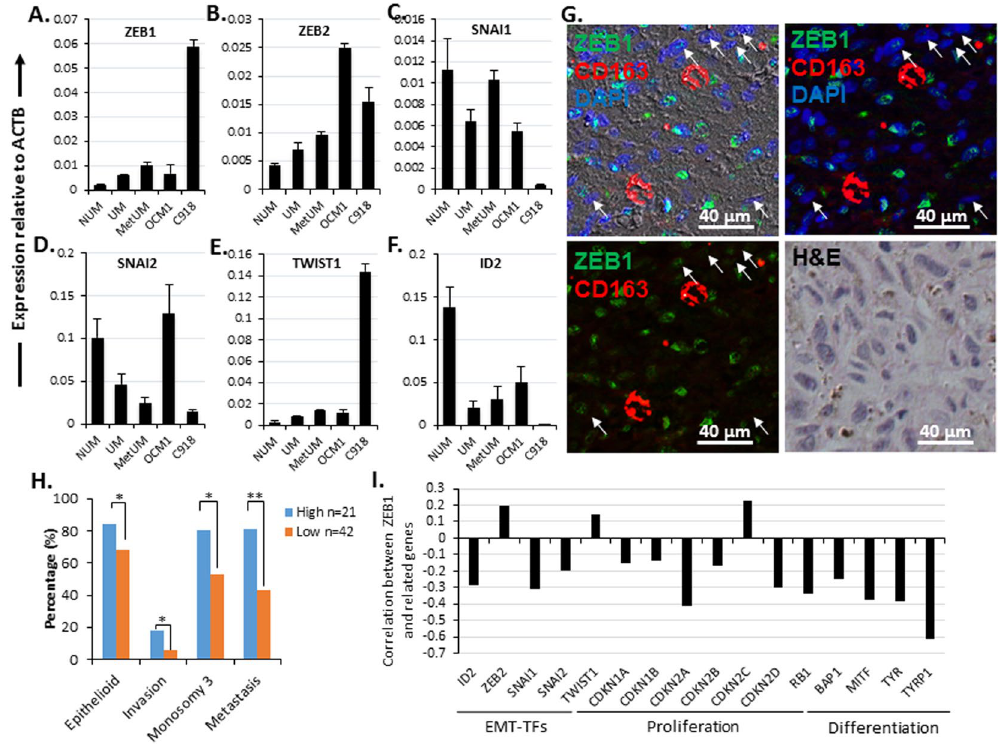
Figure 2. Expression of EMT-TFs in human NUM, UM, MetUM, OCM1 and C918 cells. Transcriptional levels of EMT-TFs were examined in NUM, UM, MetUM by microarrays 20, 21 , and in OCM1, and C918 by qPCR. The expression levels of individual genes were normalized to that of the house-keeping gene β -actin ( ACTB ). ( A ) ZEB1 ; ( B ) ZEB2 ; ( C ) SNAI1 ; ( D ) SNAI2 ; ( E ) TWIST1 ; ( F ) ID2 . ( G ) A representative patient UM of mixed phenotype showing ZEB1-stained nuclei are not elongated spindle shape and a few CD163 positive but ZEB1 negative thereby potential macrophages are scattered in the tumor. Arrows indicate elongated spindle nuclei which are ZEB1 negative and an H&E-stained section of the same area is included to show the mixed phenotype. ( H ) Statistical analyses of a large cohort of total 63 primary UMs (GES22138, Supplemental Table 4) on a number of selected tumor malignant properties in relation to their ZEB1 expression levels. After sorted from high to low expression of ZEB1 , based on preliminary assessment we assign the top one third of the UMs as ZEB1 high (n = 21) and the bottom two third of the UMs as ZEB1 low (n = 42). ( I ) Correlation coefficients are calculated based on the microarray data set (GES22138), showing that expression of critical genes involved in EMT, cell proliferation and differentiation is correlated to that of ZEB1 . Mean (M) ± standard deviation (SD). ‘ * ’ Indicates Student’s t-test p ≤ 0.05, ‘ ** ’ Indicates Student’s t-test p ≤